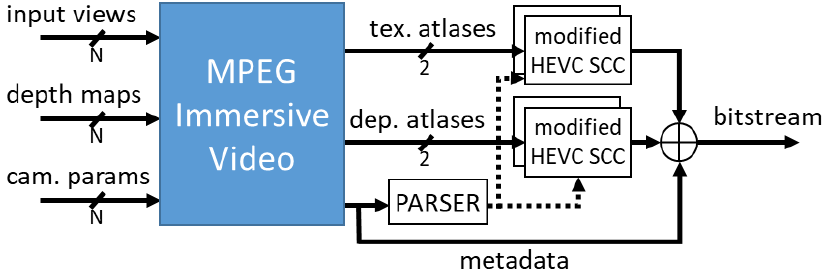
Figure 3. Simplified MPEG immersive video coding scheme with modified HEVC SCC encoder controlled by MIV metadata; input data: N input views, corresponding depth maps, and camera parameters (intrinsic and extrinsic); MIV encoder output — metadata and 4 video streams, including two texture atlases with corresponding depth atlases; each video stream is independently encoded using modified HEVC SCC encoder, encoding parameters (e.g., QP) are controlled by MIV metadata.